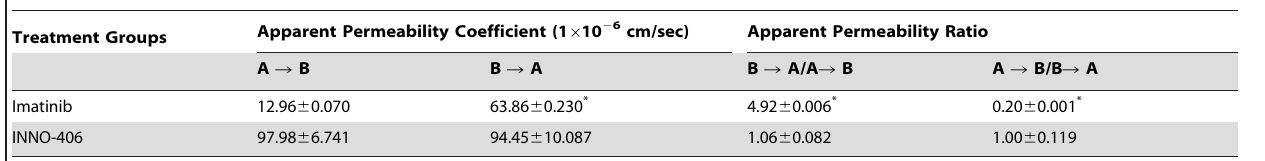
Table 2. Directional Apparent Permeability Comparison of Drug Analogues.